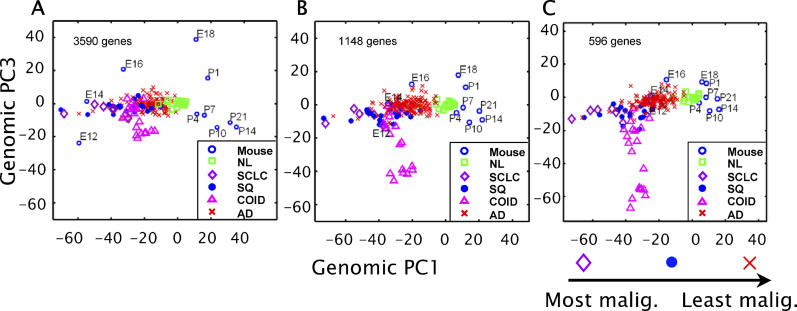
The Projection of NL and Lung Cancer Genomic Profiles onto the Genomic Mouse Lung Development Frameworks Constructed from Three Different Mouse Gene SubsetsIn all cases, genomic PC1 of mouse lung development is positively correlated with lung development time. Mouse lung sample placements (blue circles) are nearly contiguous as a function of their stage of development. The separation between the human lung cancer subtypes in this mouse genomic development framework is defined by a class differentiation measure (see
Methods).
Table S3 gives the score
pca values for the top-union algorithm for these gene set size parameters. Mouse, mouse lung development stages.
(A) Human lung samples projected onto the mouse lung development genomic framework (genomic PC1 and PC3) of all 3,590 genes.(B) Same as (A), but for the mouse development framework constructed from the subset of 1,148 significantly differentially expressed genes in the human lung cancer subtypes.(C) Same as (B), but for the mouse development framework constructed from a further subset of 596 genes of the 1,148.